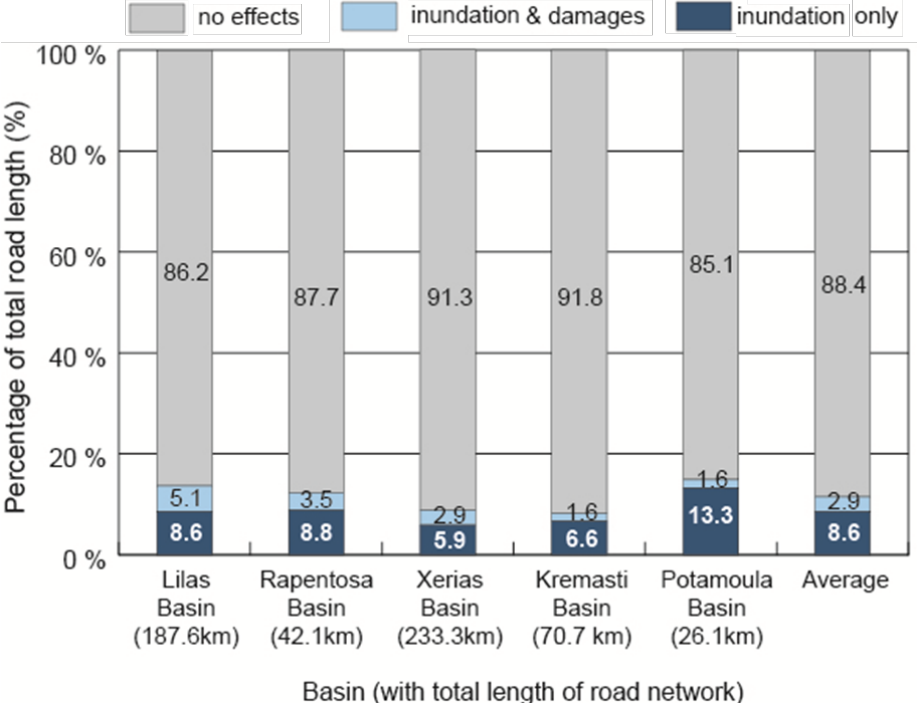
Figure 5. Percentage of total road length of the examined basins that experienced temporary inundation and damages during the